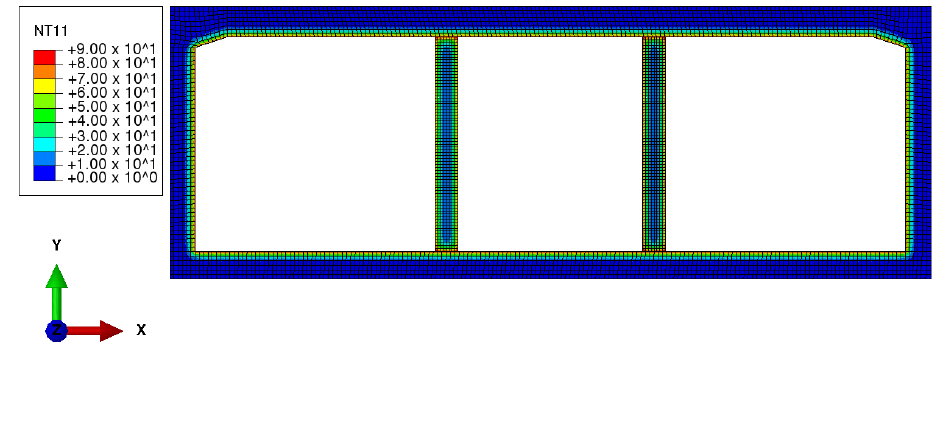
Figure A1. Temperature distribution obtained by prescribing a uniform surface temperature history, 30 min after the start of the thermal loading: overview over the whole